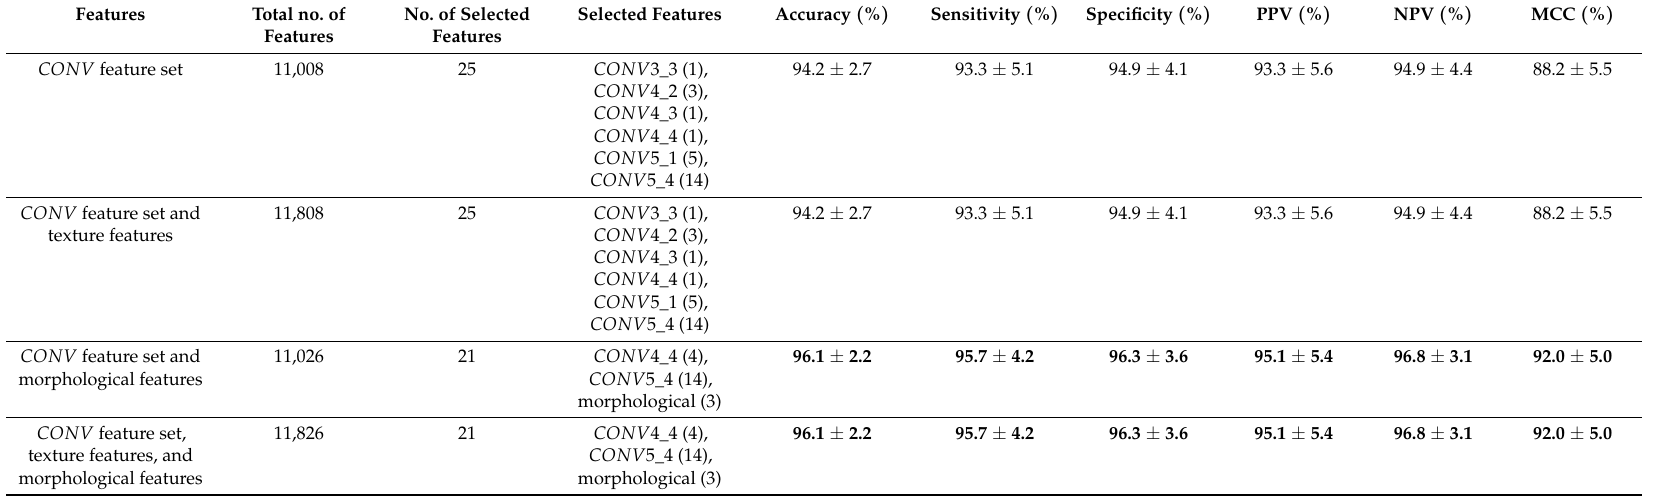
Table 4. The BUS image classification results obtained using the CONV feature set compared with the classification results achieved by combining the CONV feature set with handcrafted texture and morphological features. For the six performance metrics, the mean ± standard deviation values are computed across the ten folds of the cross-validation procedure performed using Dataset